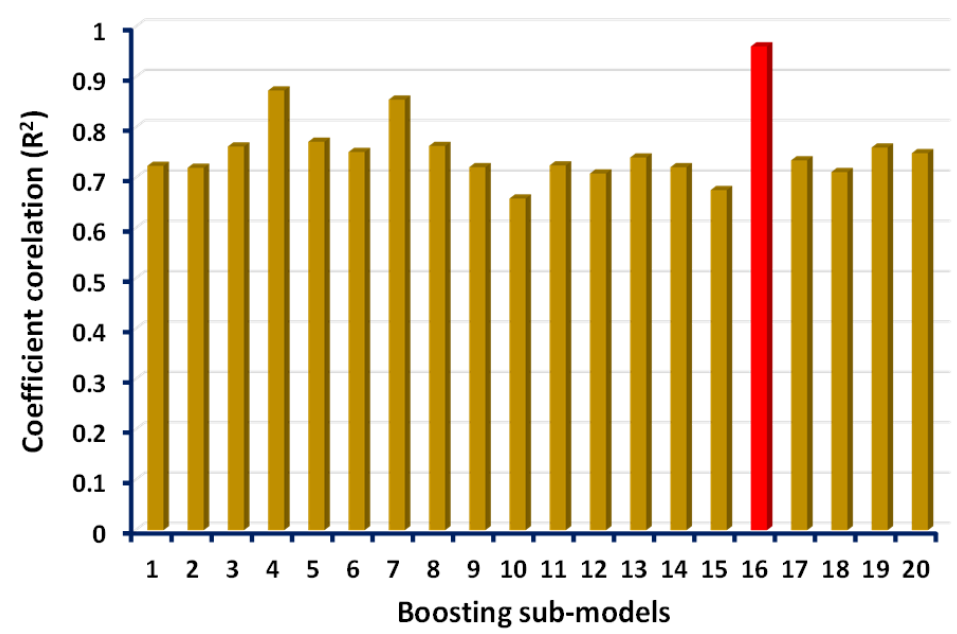
Figure 11. Sub-models of the boosting approach indicating the coefficient correlation (R2).